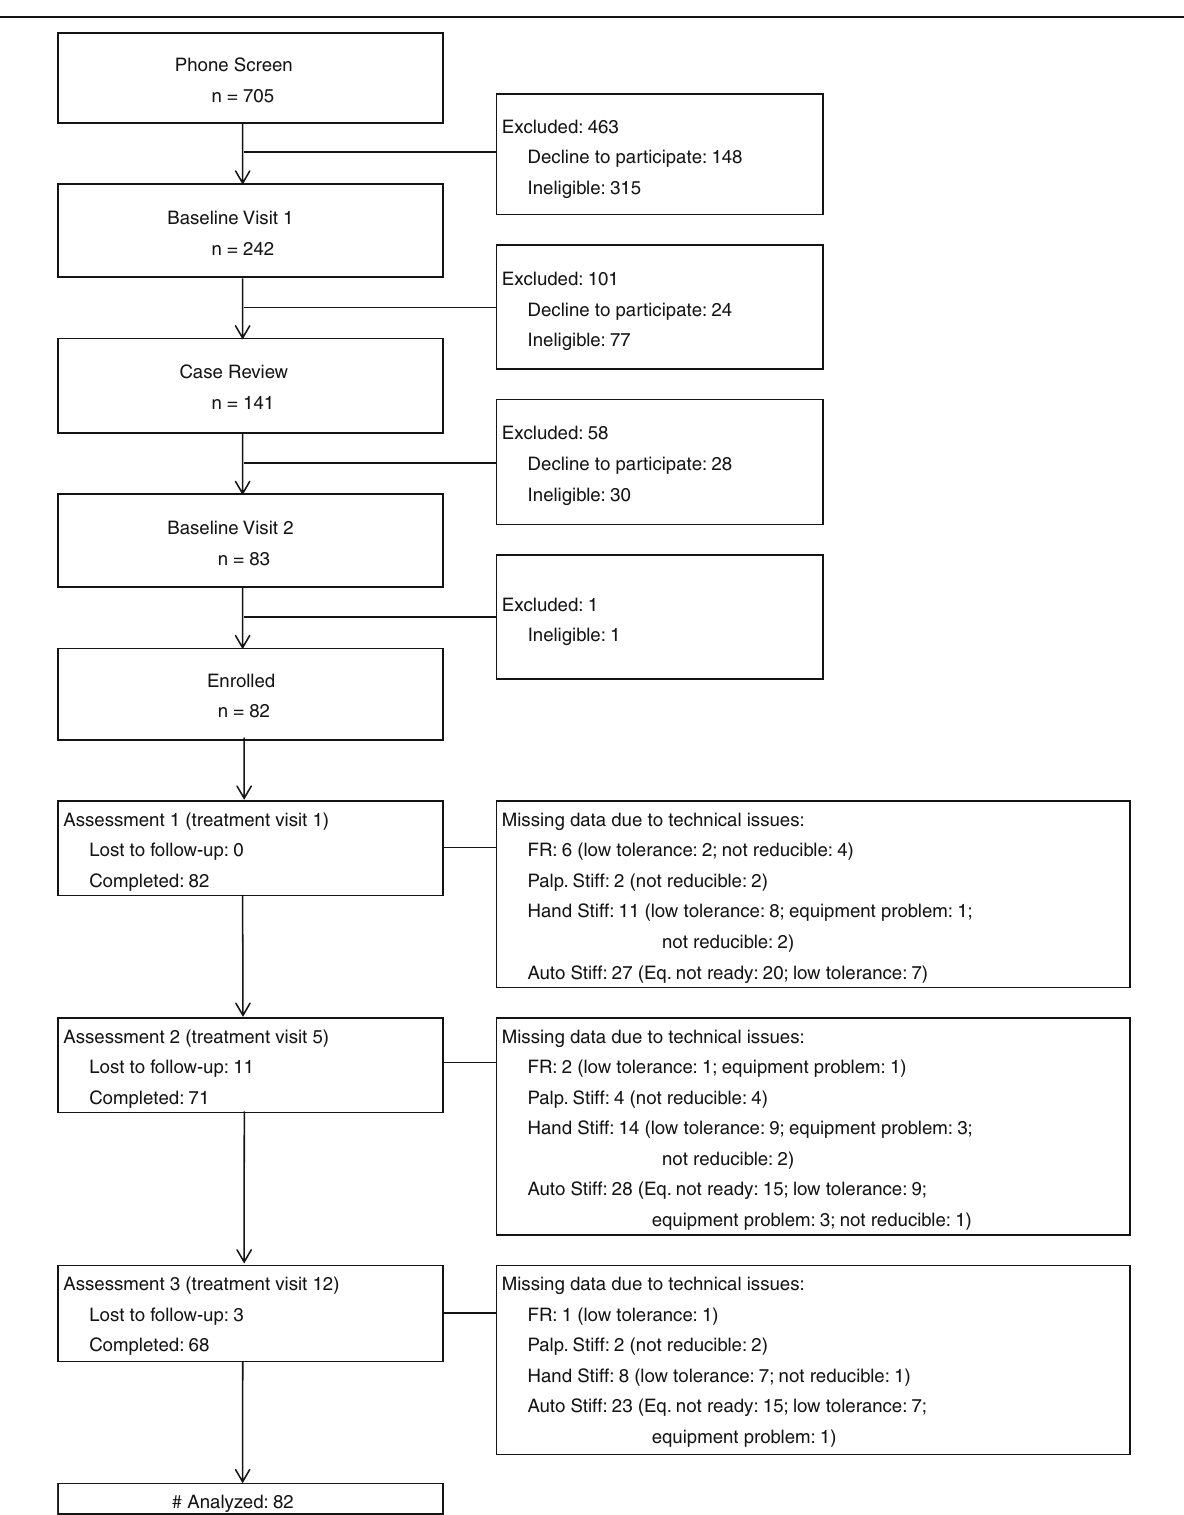
Fig. 1 Study CONSORT flow diagram. FR: flexion relaxation; Palp. Stiff: had palpation stiffness assessment; Hand Stiff: hand-held device stiffness assessment; Auto Stiff: automated indenter stiffness assessment; Eq. not ready: equipment upgrade was needed for an unexpected safety concern, not ready for